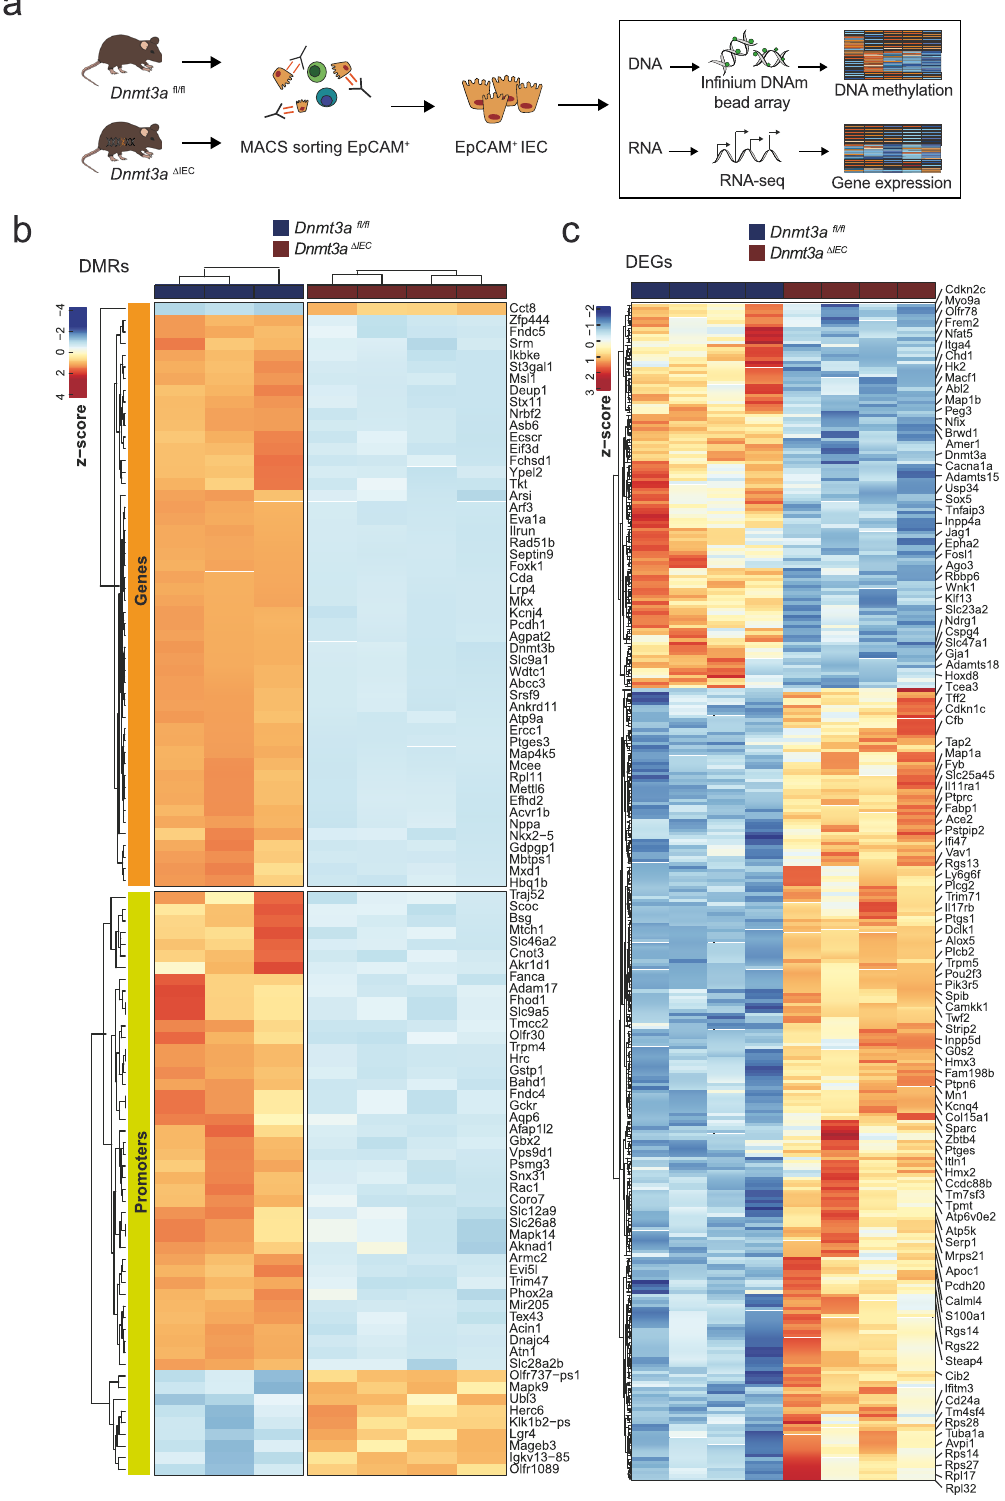
Fig. 4| Transcriptomeandmethylomepro fi lesin Dnmt3a -de fi cientIECinvivo. a Summary of experimental setup. Graphical elements modi fi ed from refs. 17, 74. EpCAM positive IECs were obtained from colon tissues and used for RNA- sequencingandmethylationpro fi lingusingIn fi niumMouseMethylationBeadChip